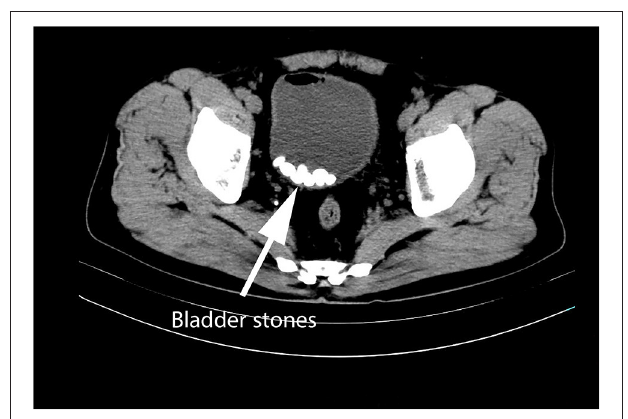
FIGURE 1 | An example of CT image of typical multiple bladder stones.